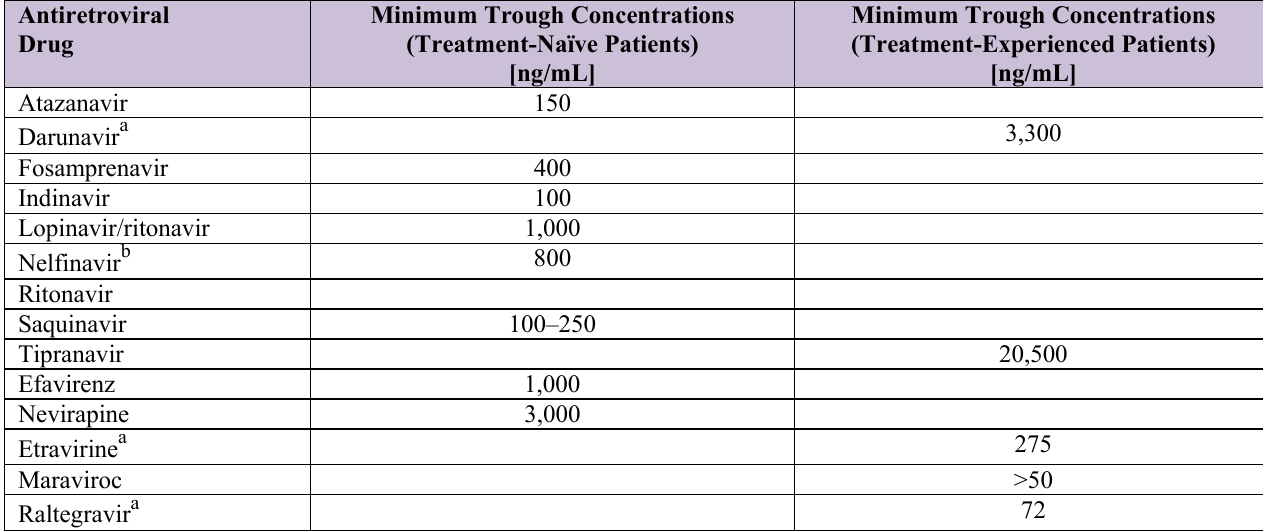
Table 3. Minimum antiretroviral trough concentration targets for treatment-naïve and treatment-experienced patients